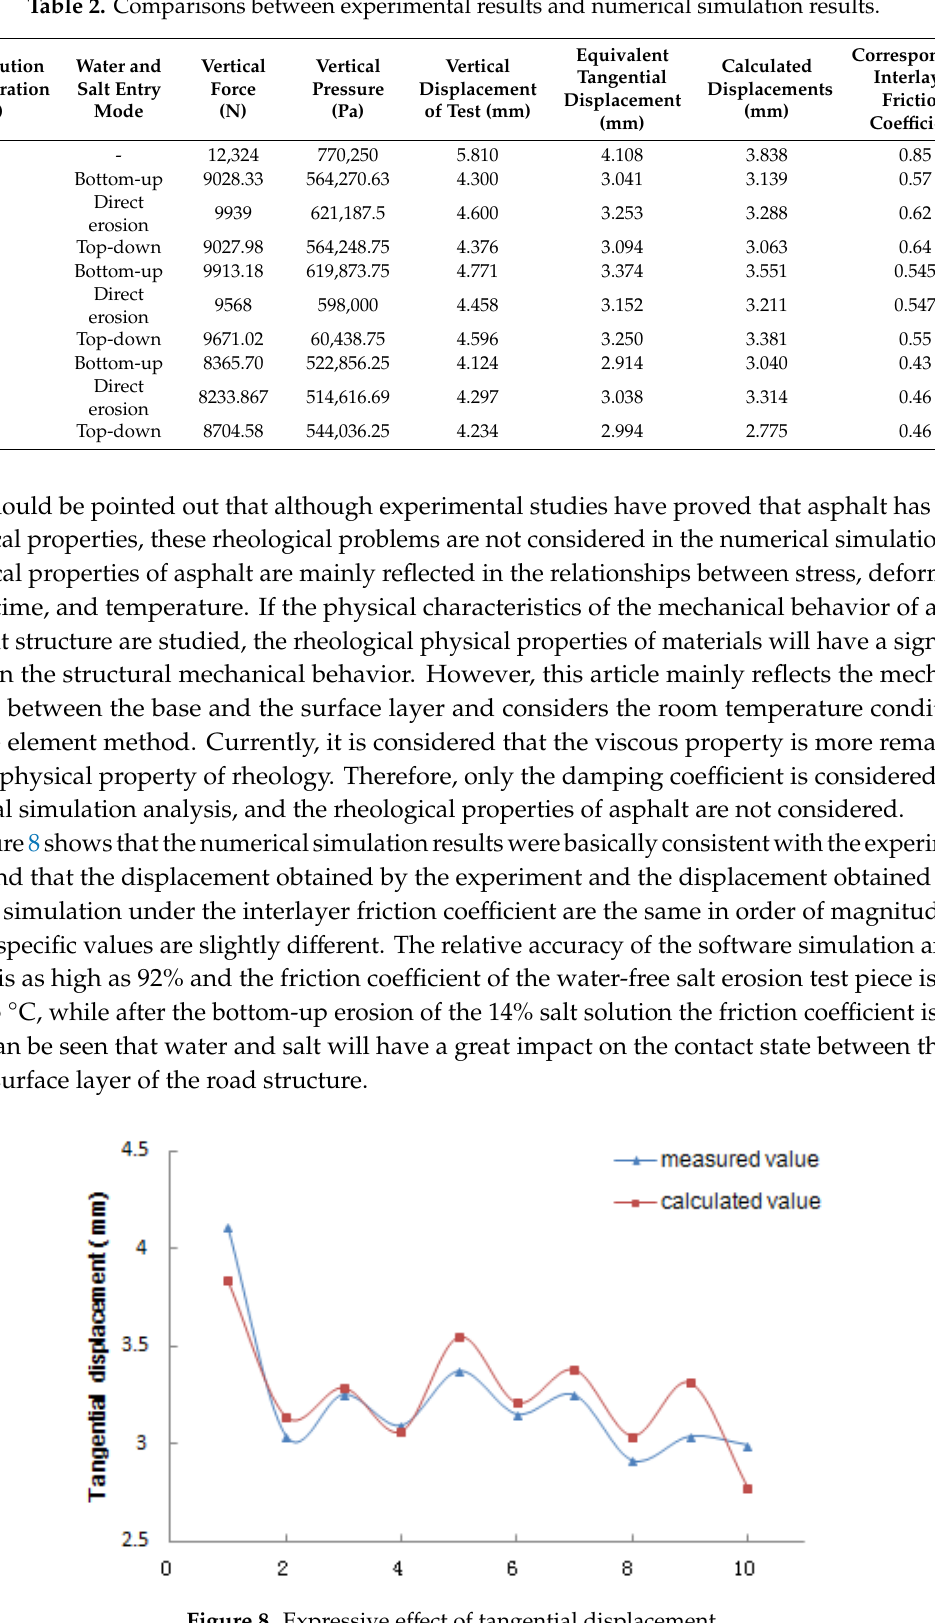
Table 2. Comparisons between experimental results and numerical simulation results.